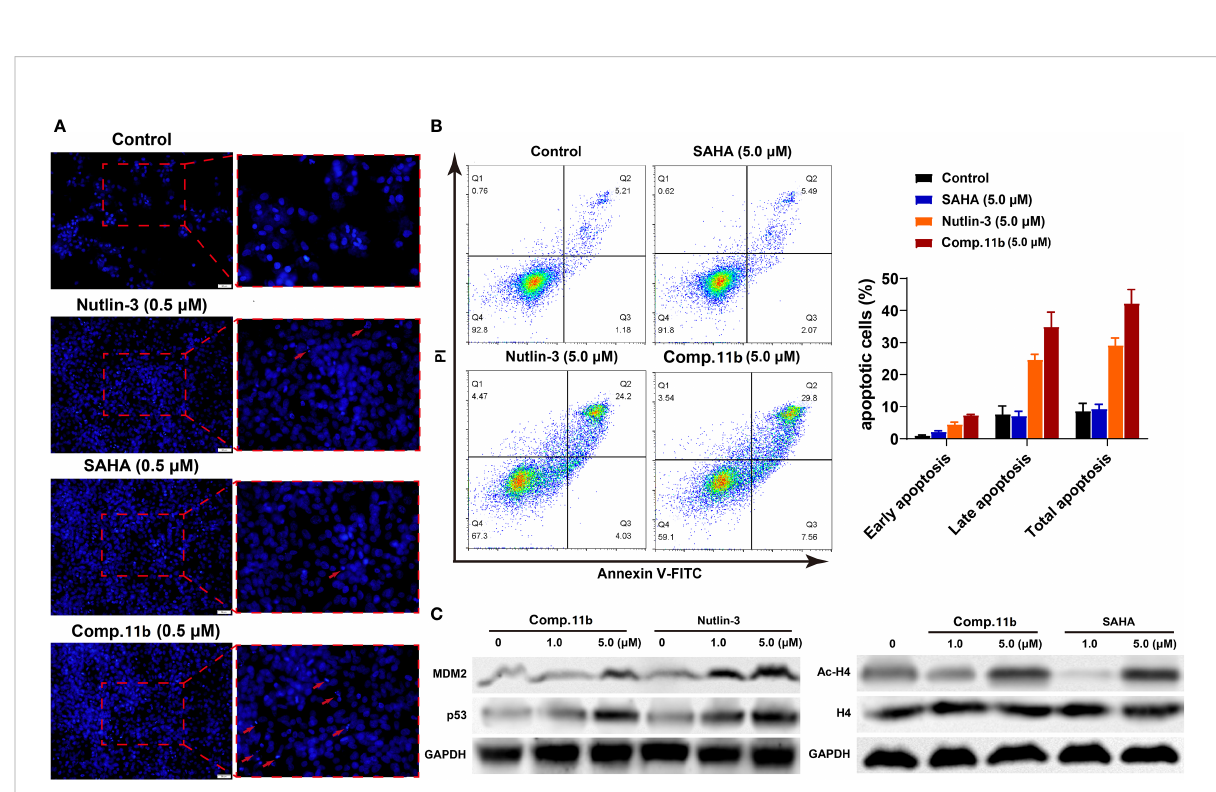
FIGURE 9 Synthesis of target compounds 7a-7y , 9a-9e , 11a-11b , 13a , 15a-15c . Reagents and conditions: (A) HATU (1.2 equiv), DIPEA (2.0 equiv), DCM, rt; (B) TFA/DCM=1:3,